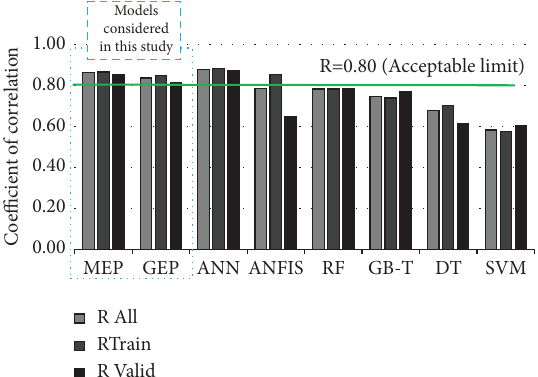
Figure 9: Comparison of correlation coefcient for various computational intelligence approaches employed in this